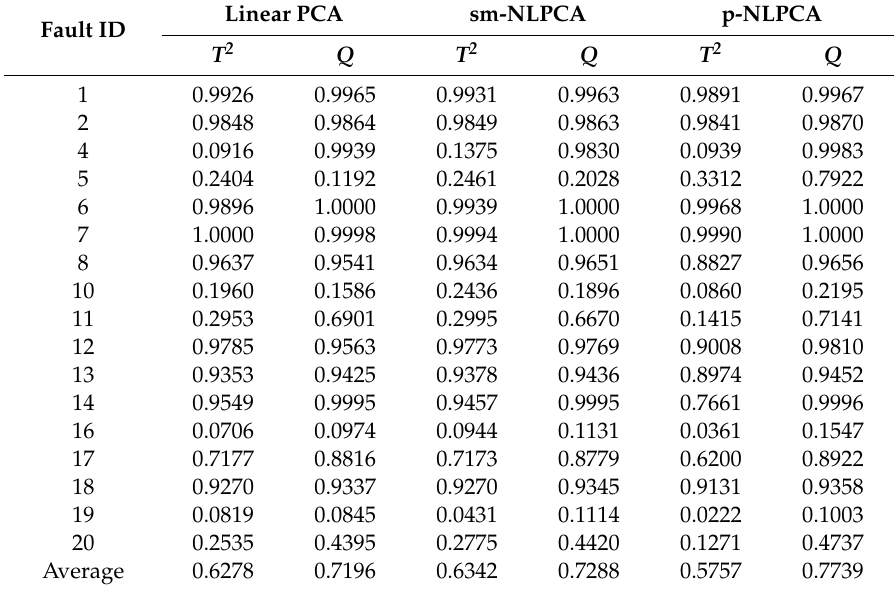
Table 12. Detailed process monitoring results obtained using linear PCA and two NLPCA methods (FAR = 0.01 for normal test